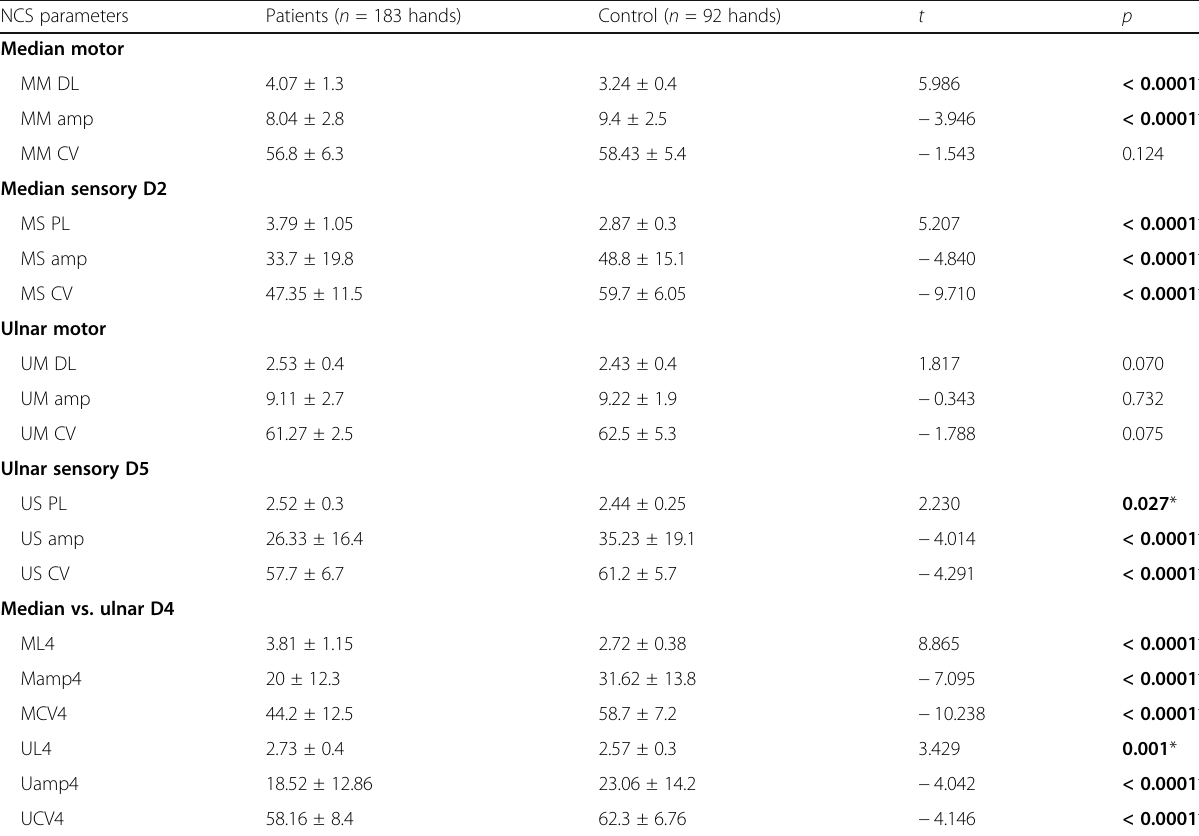
Table 2 Comparison of nerve conduction study parameters between case and control groups NCS